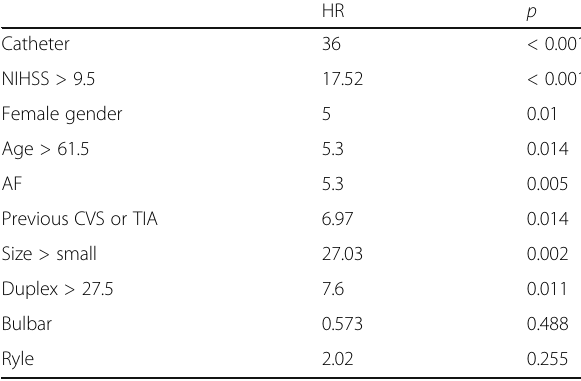
Table 4 Risk factors for post-ischemic stroke UTI